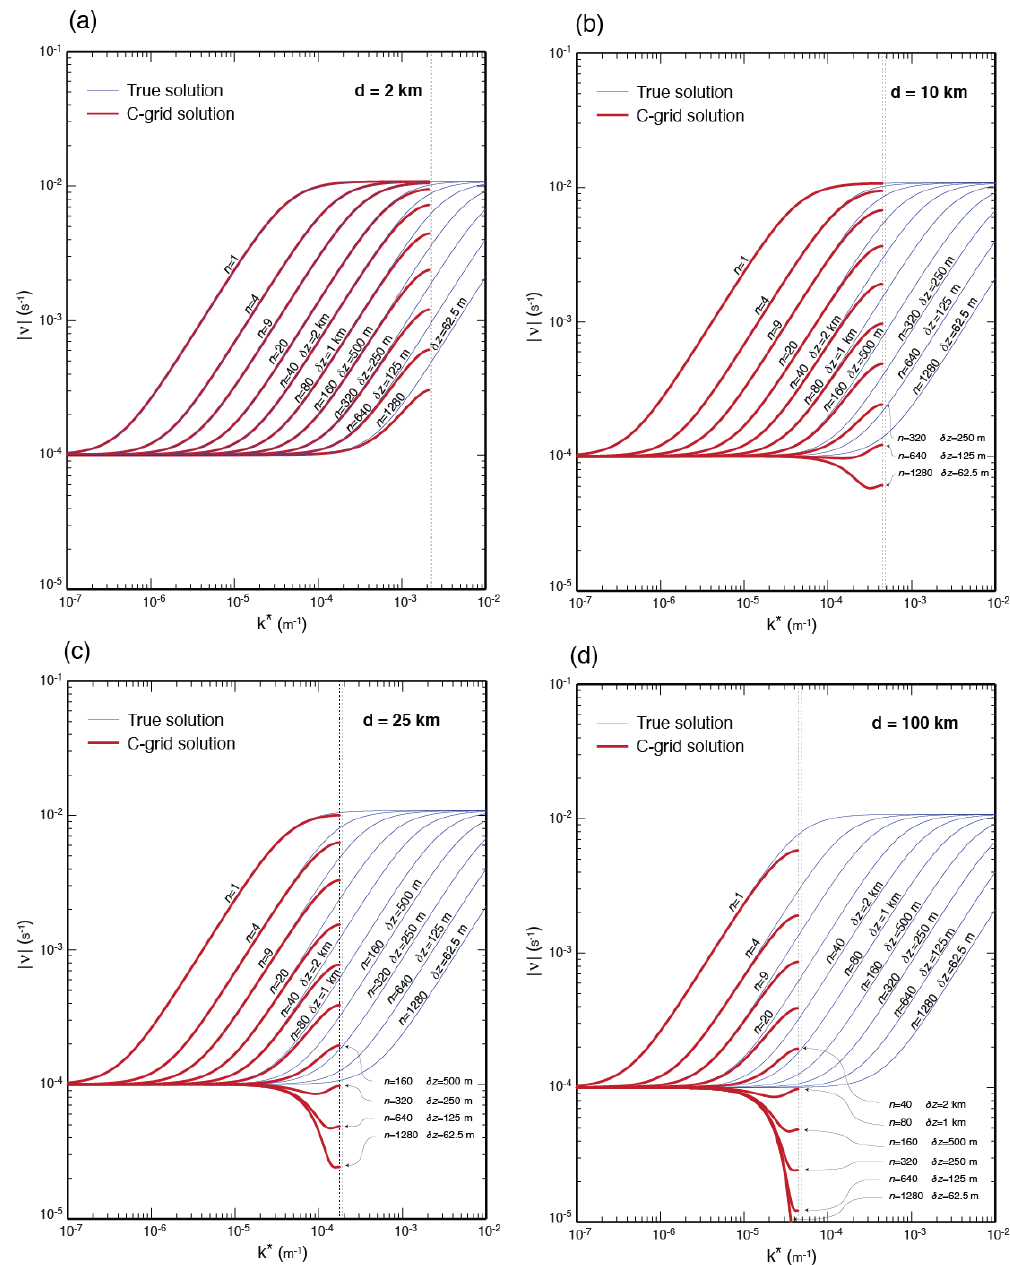
Figure 3. Same as Fig. 2 but for the C